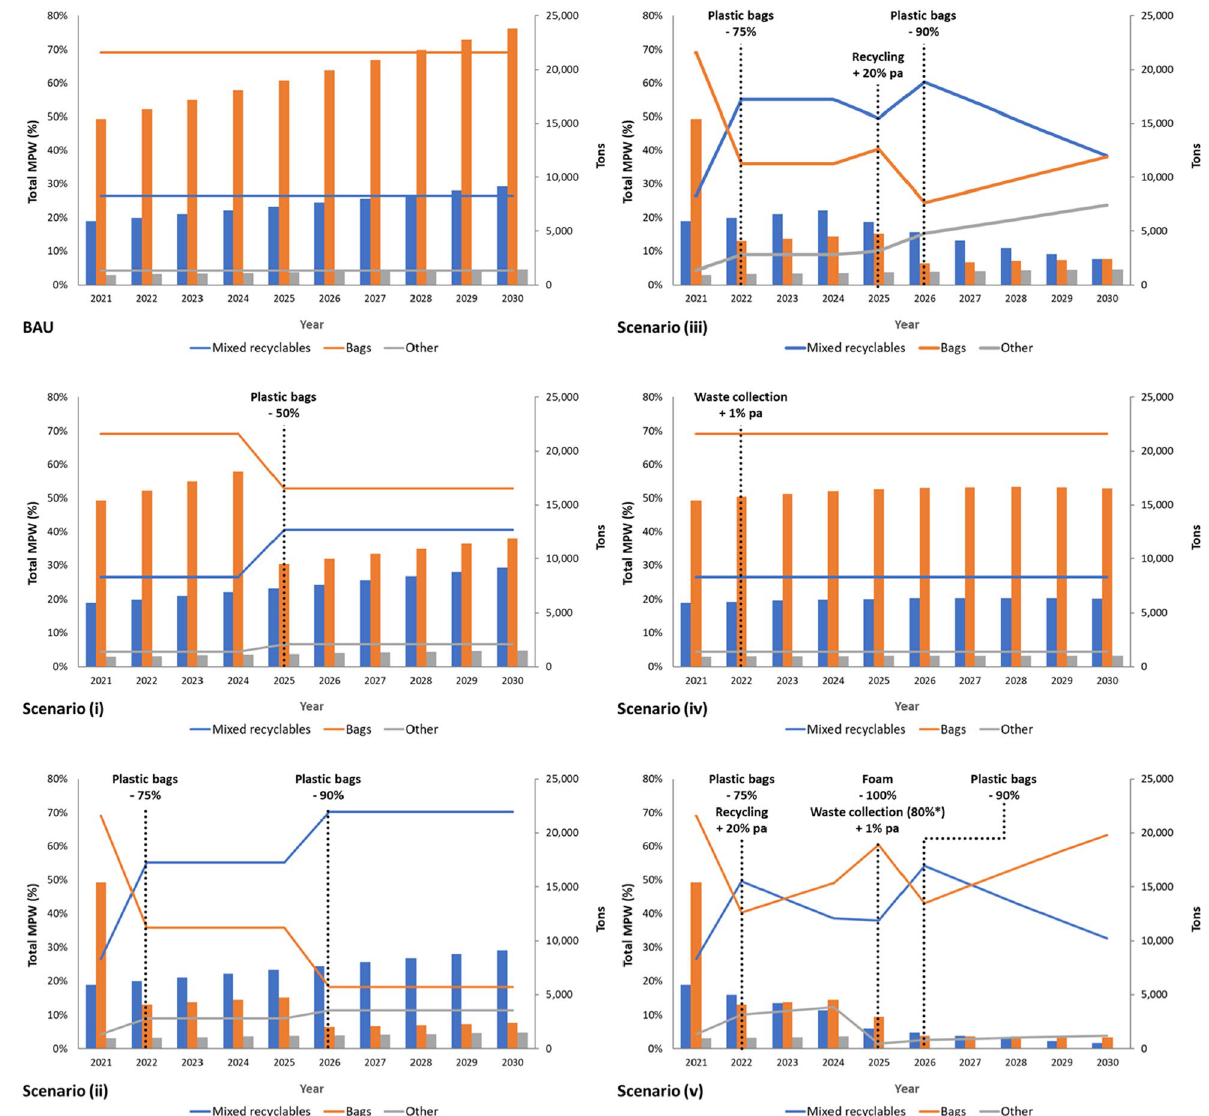
Figure 4. Analysis of Scenarios (i) to (v) and the impact that policy improvements have on individual components of the estimated MPW, which are: mixed recyclables (PET bottle, HDPE), bags and others (foam, film). Total annual change in MPW (tons) shown by bars and relative change (%) shown by lines. Note Scenario (v) *waste collection is 80% for all provinces in 2025, except for the floating communities with